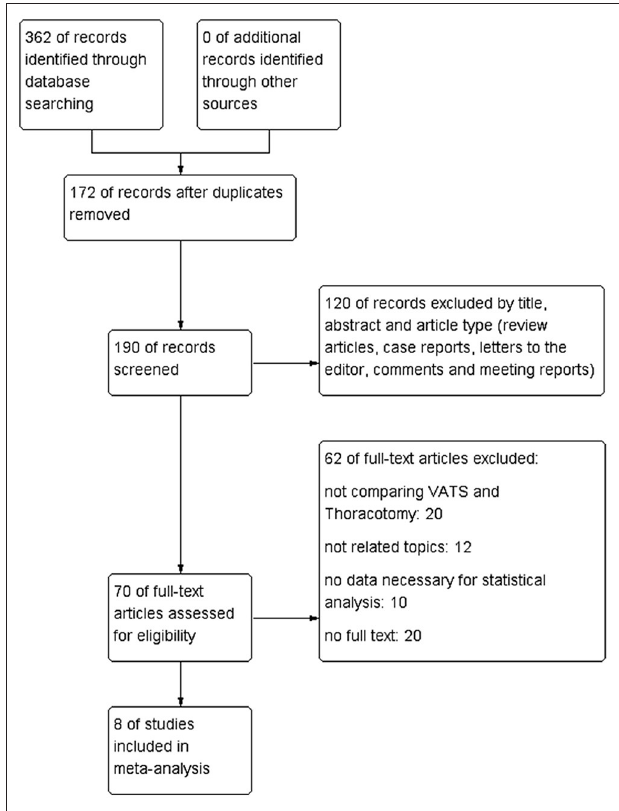
FIGURE 1 | Flow chart of literature search strategies.